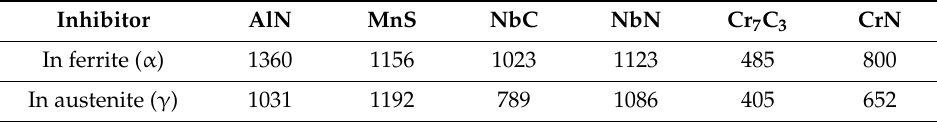
Table 2. The beginning-precipitating temperature of the inhibitors in the specimens / ◦